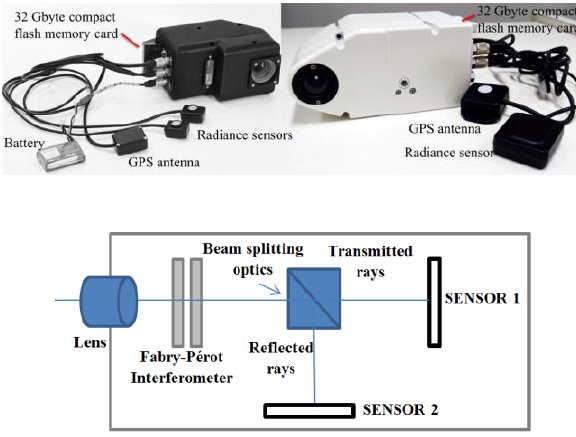
Figure 2. Band acquisition in a hyperspectral cube during an aerial